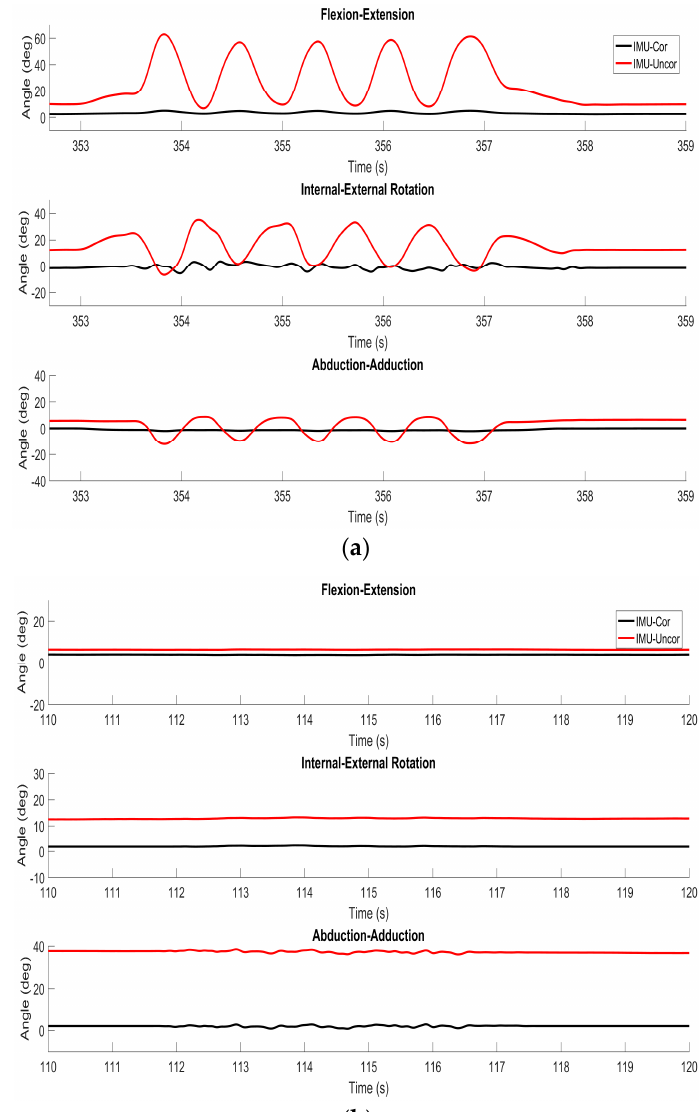
Figure 5. Example results from ( a ) pure internal/external rotation trial, and ( b ) pure abduction/adduction trial. The differences between the CMM truth data and IMU-derived estimates with the correction (black) and without the correction (red) of flexion/extension, internal/external rotation and abduction/adduction are plotted for a representative time period.